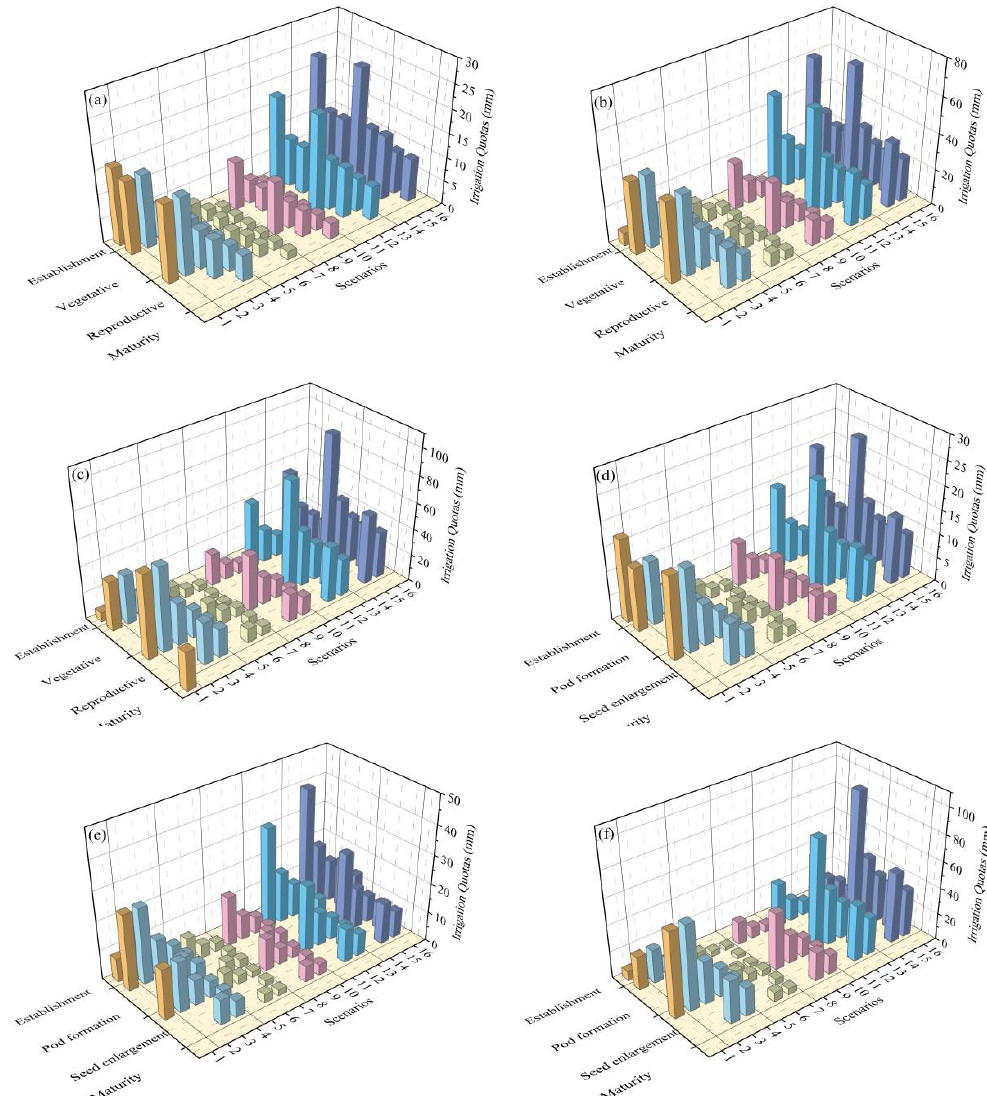
Figure 6. Irrigation scenarios. ( a ) corn wet year, ( b ) corn normal year, ( c ) corn dry year, ( d ) soybean wet year, ( e ) soybean normal year, ( f ) soybean dry year.